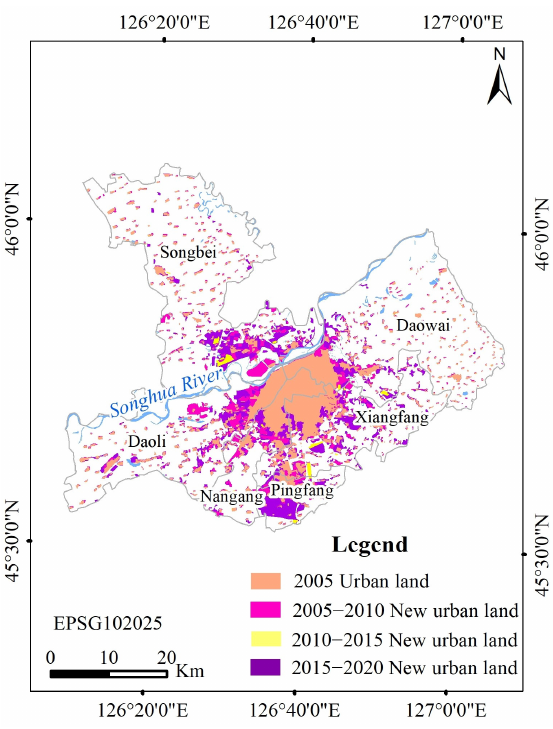
Figure 4. Spatial distribution of built-up land changes in Harbin from 2005 to 2020.